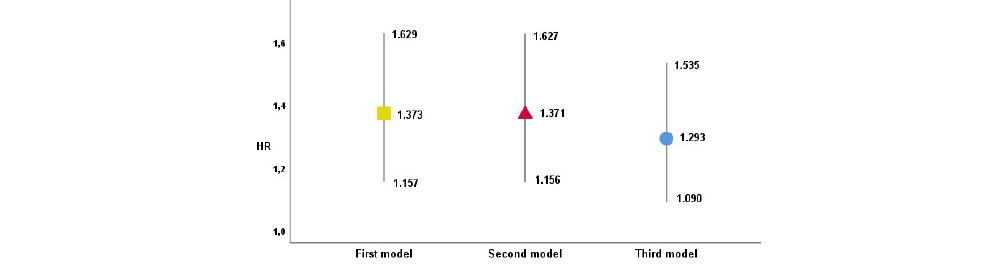
Figure 2 ‒ Risk of MACE occurrence with different wGRS adjustments. wGRS Hazard ratios (HR) from Cox regression analysis for prediction of MACE on 3 different models: 1 st adjusted for age and gender, 2 nd including TRFs and 3 rd including TRFs and clinical variables. Statistically significant for each model (p<0.0001; p<0.0001 and p=0.003,